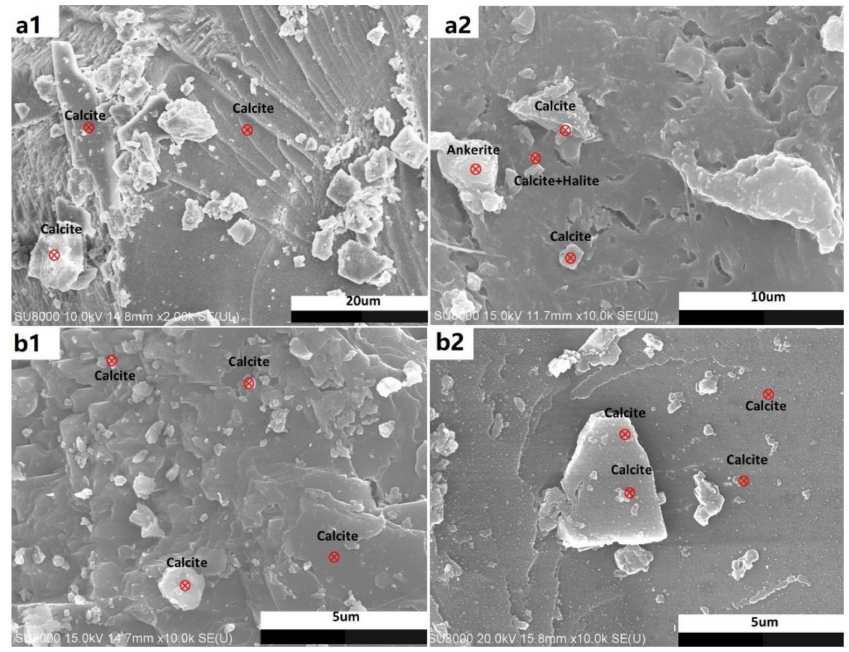
Figure 7. Scanning electron photomicrographs of rock samples: ( a1 ) Case 1 before experiment; ( a2 ) Case 1 after experiment; ( b1 ) Case 3 before experiment; ( b2 ) Case 3 after